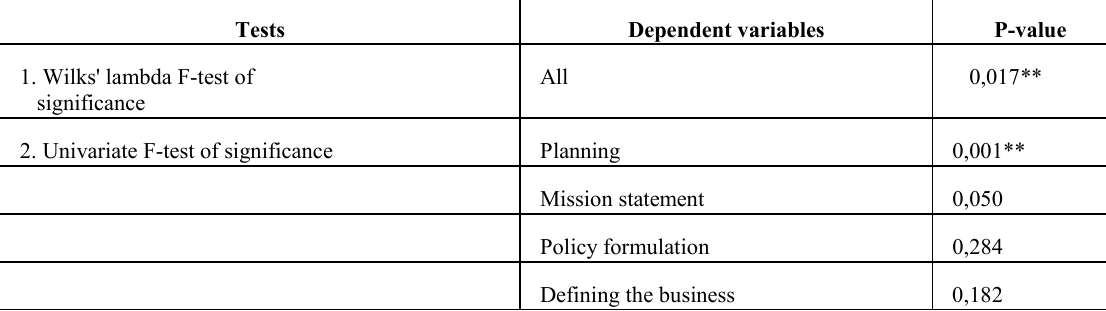
Table 2: The results of the tests to investigate relationships between role culture and strategy formulation